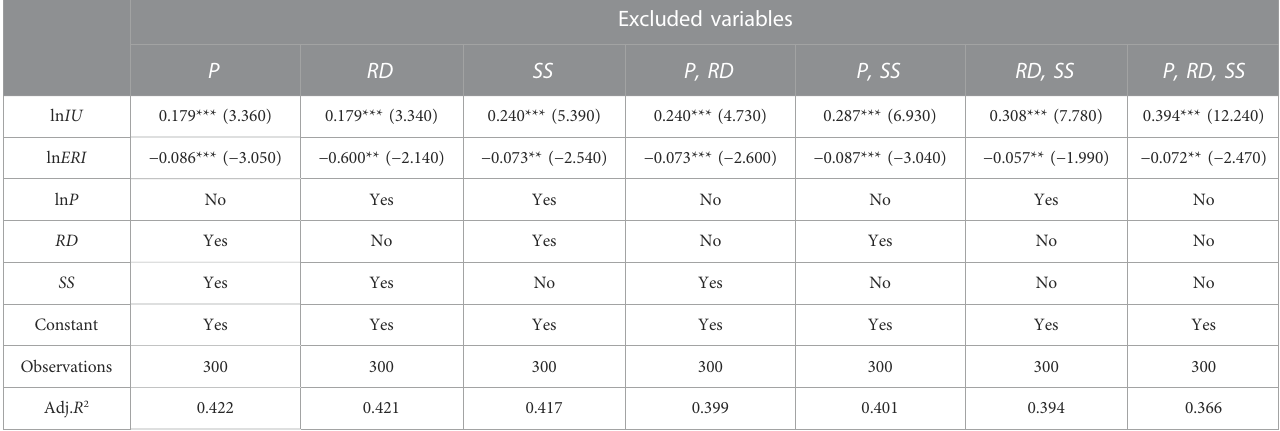
TABLE 7 Robustness test 2: Excluded variables.